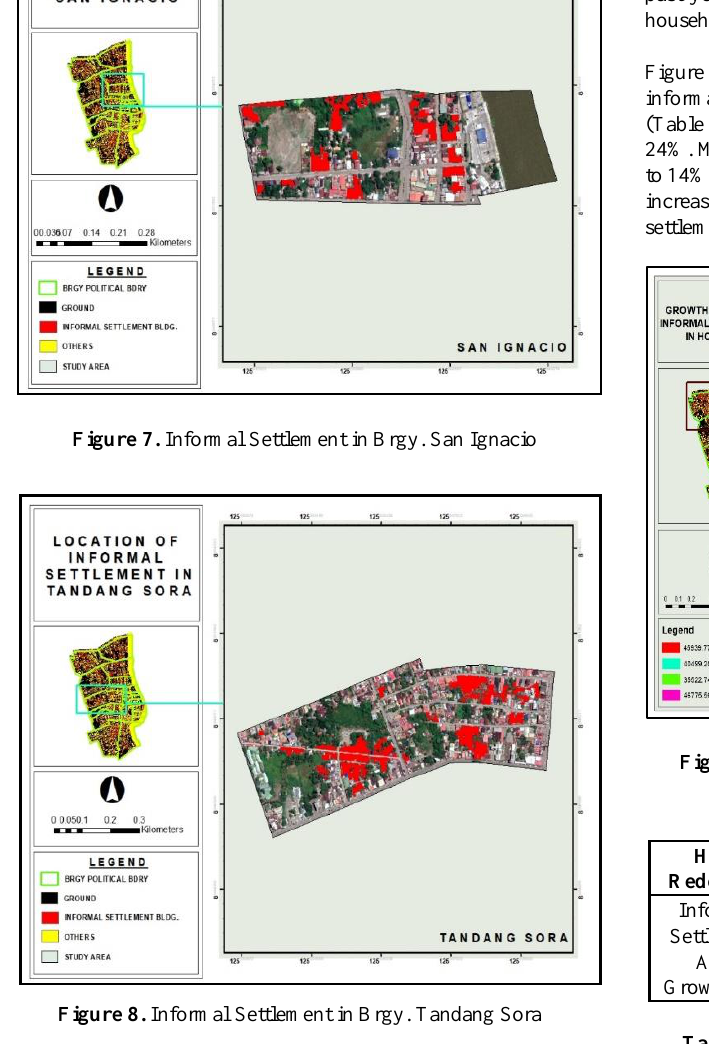
Table 2. Informal Settlement Growth in Percentage in Brgy. Holy Redeemer